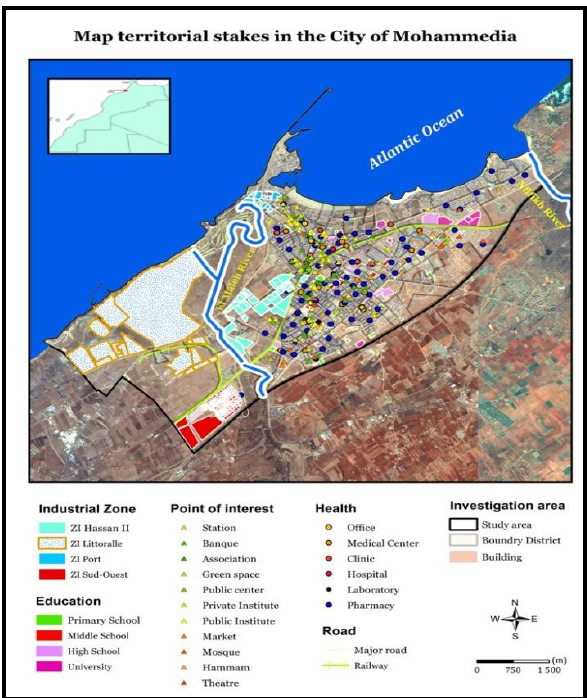
Figure 6. Map territorial stakes in the City of